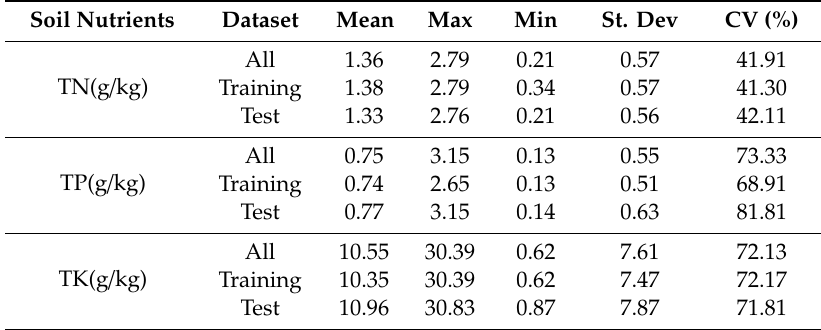
Table 1. Descriptive statistics of soil nutrient contents from 75 soil samples in Guangdong, China (TN: total nitrogen; TP: total phosphorus; TK: total potassium; St. Dev: standard deviation; CV: coefficient of variation).